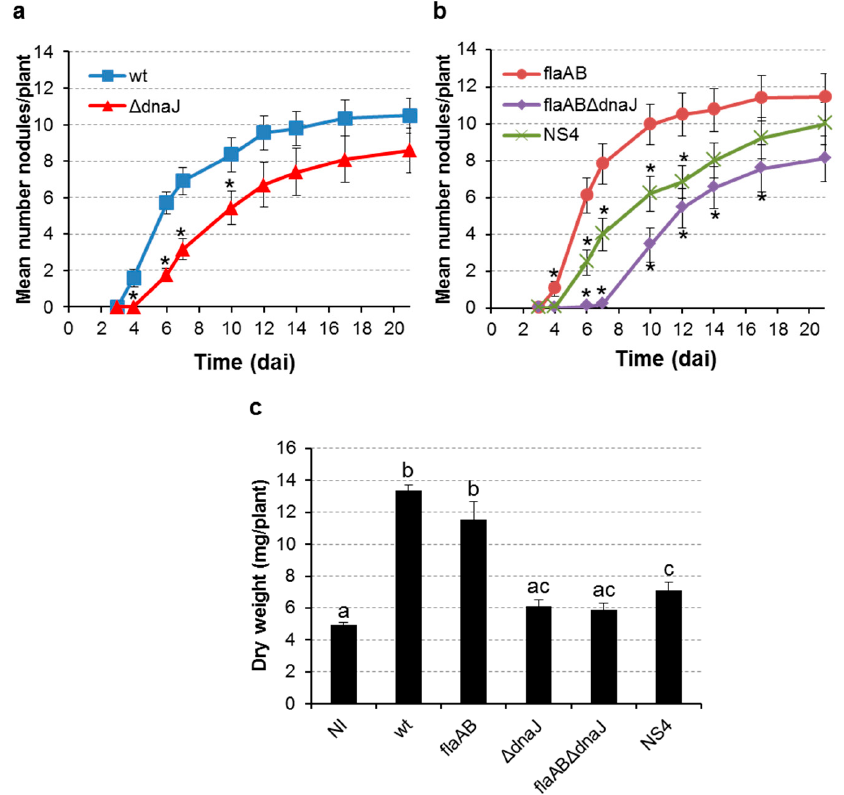
Figure 7. The symbiotic phenotype of S. meliloti dnaJ mutants on alfalfa plants. Nodulation kinetics of ( a ) GR4 strain (wt) and its derivative dnaJ deletion mutant ( ∆ dnaJ), and ( b ) the flagellaless strain GR4flaAB (flaAB) and its dnaJ deletion (flaAB ∆ dnaJ), and transposon insertion (NS4) derivative mutants. Asterisks indicate significant differences compared to the parental strain according to an ANOVA test ( p < 0.05). ( c ) Symbiotic efficiency of S. meliloti strains, as determined by the shoot dry weight of alfalfa plants 21 days after inoculation (dai). NI, noninoculated plants. Different letters indicate significant differences according to an analysis-of-variance (ANOVA) test ( p < 0.05).